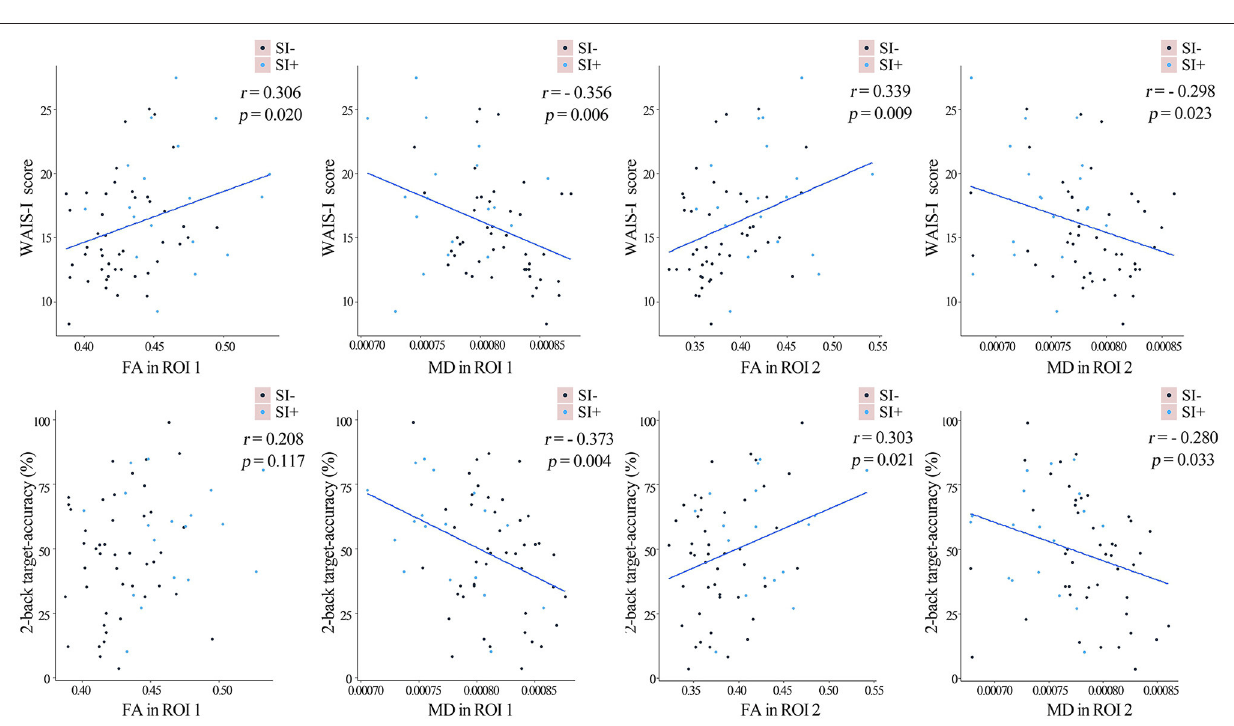
In order to further investigate the relationship between